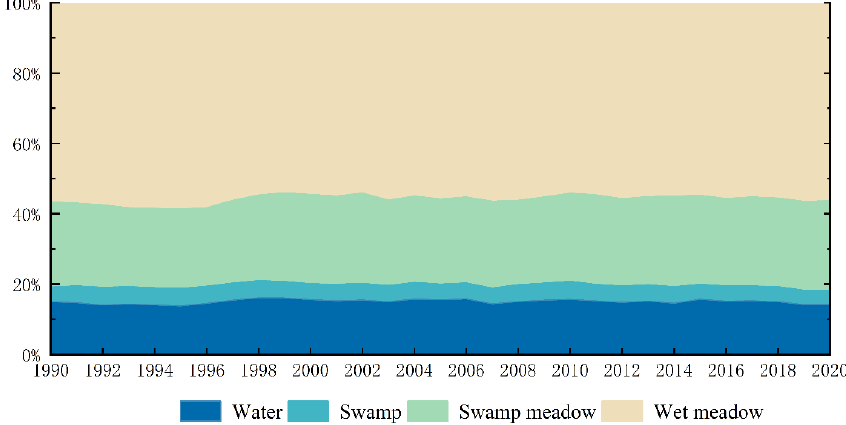
Figure 8. Overall changes in the Maqu wetland area from 1990 to 2020.